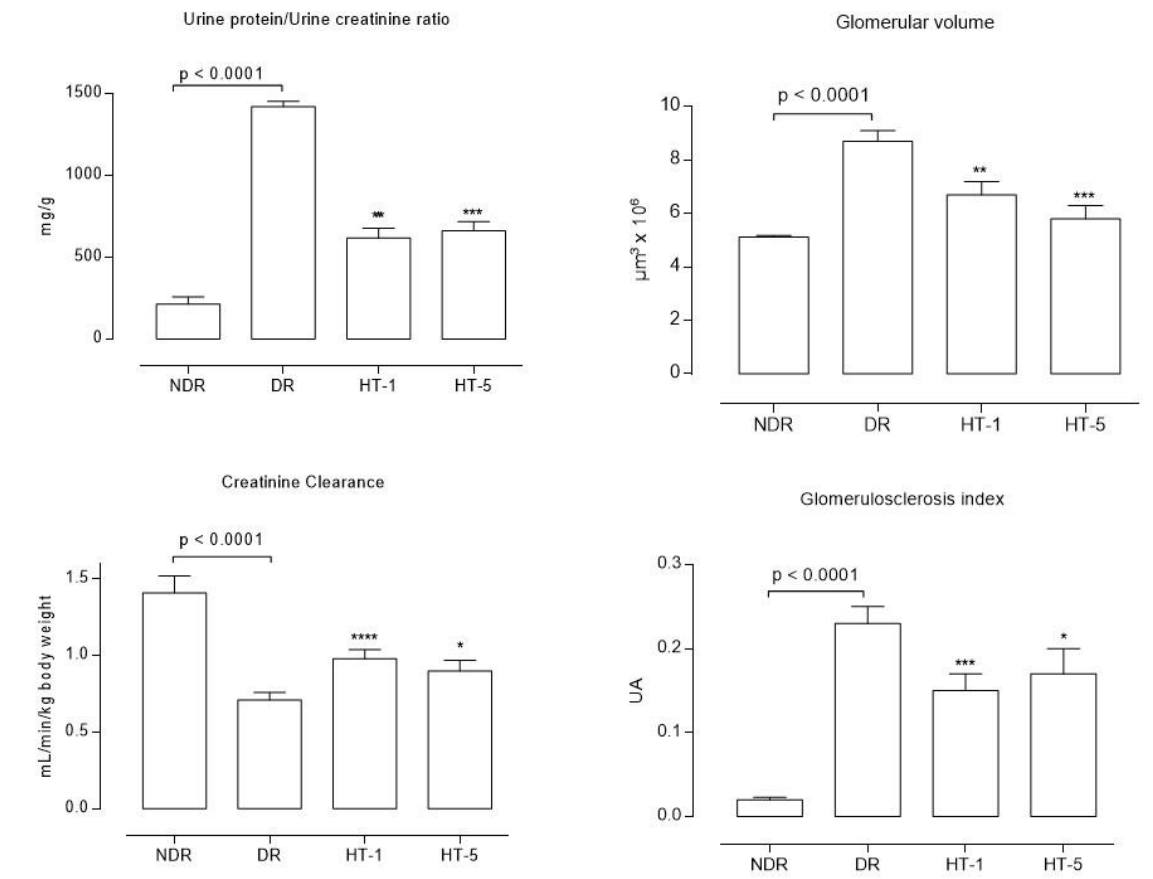
Figure 2. Mean values (mean ± standard error of the mean) of the proteinuria/urine creatinine ratio, calculated creatinine clearance, glomerular volume, and glomerulosclerosis index after eight weeks of follow up in control nondiabetic rats (NDR), control diabetic rats (DR), and DR treated with hydroxytyrosol 1 mg/kg/day p.o. (HT-1) or 5 mg/kg/day p.o. (HT-5). N = 10 rats per group. * p = 0.04, ** p = 0.001, *** p = 0.004, **** p < 0.0001, with respect to DR.